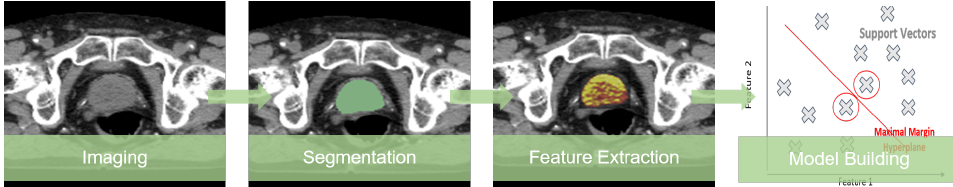
Figure 1. Radiomic studies